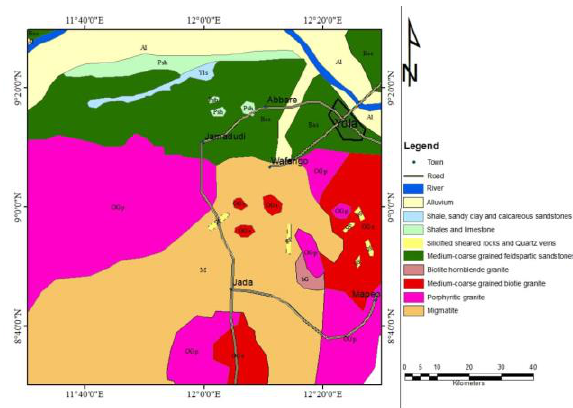
Figure 1: Geologic map of Nigeria showing the study area in outline (Obaje, 2009)